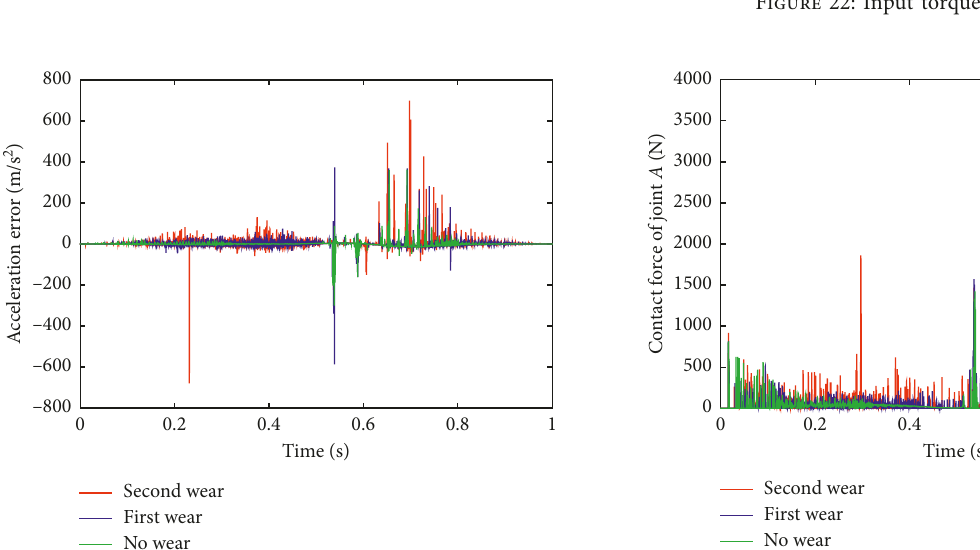
Figure 22: Input torque of crank 4.